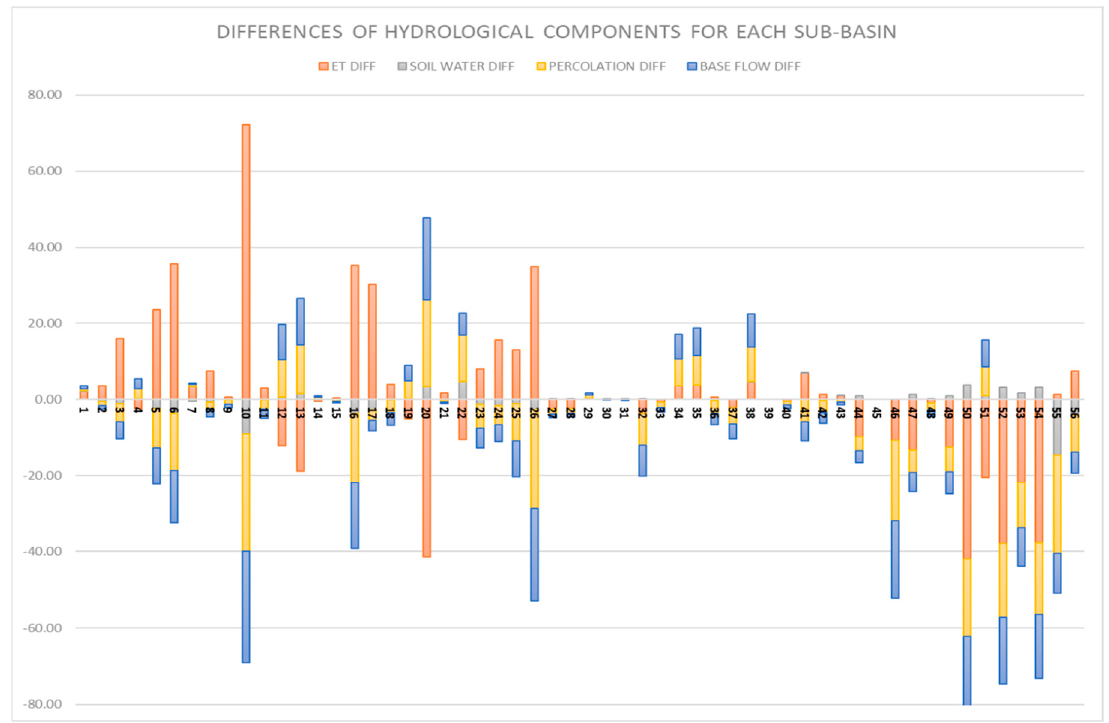
Figure 4. Differences of long ‐ term annual average ET, soil water, percolation and base flow. Figure 4. Di ff erences of long-term annual average ET, soil water, percolation and base flow.